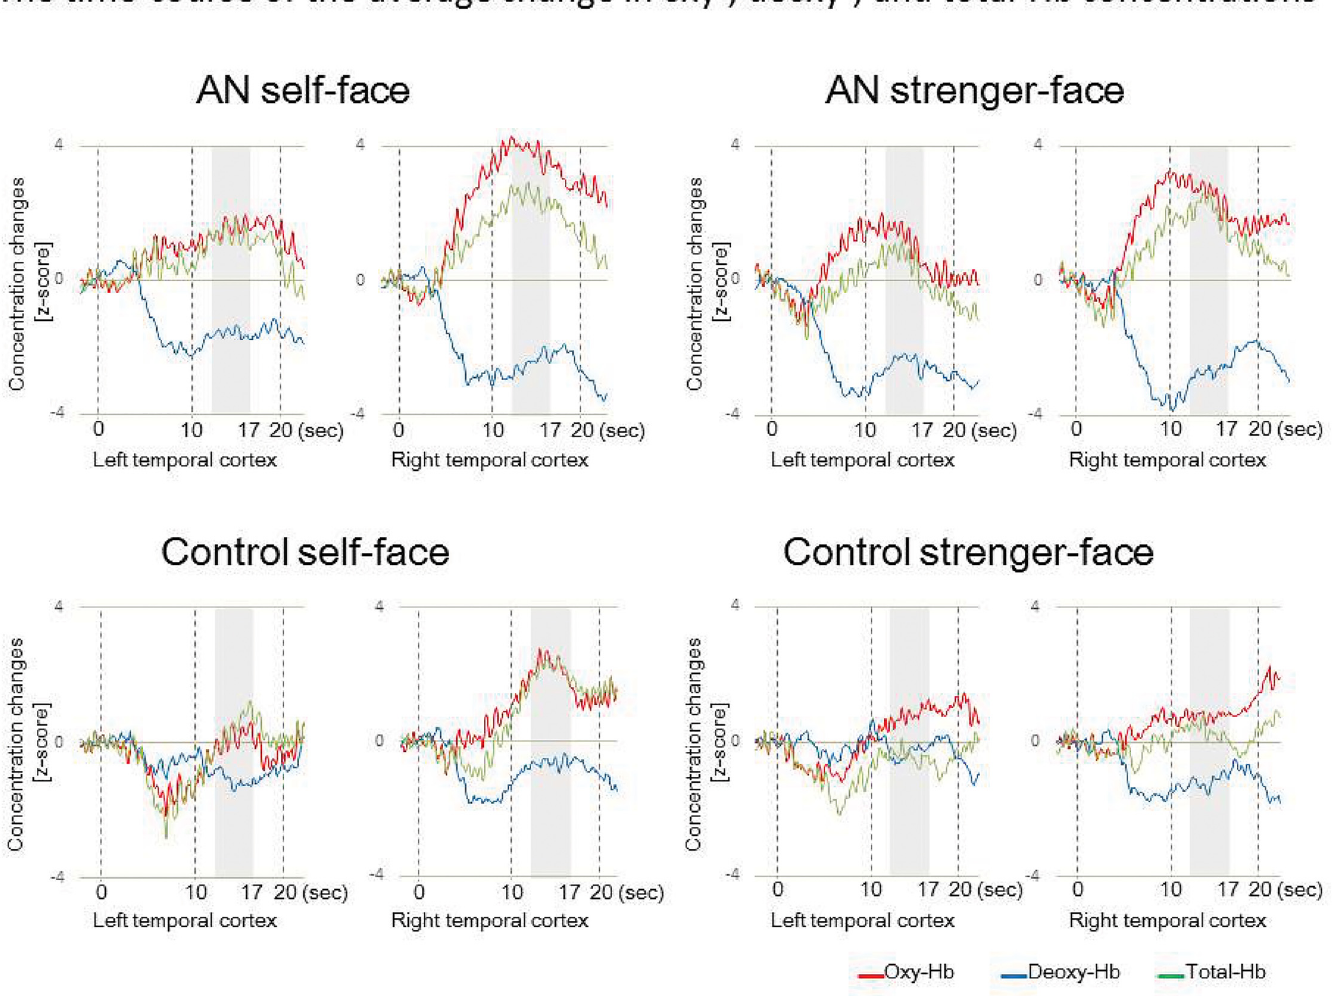
Fig 3. The time-course of the average change in oxy-Hb, deoxy-Hb, and total-Hb concentrations. The time-course of the average change in oxy-Hb, deoxy-Hb, and total-Hb concentrations in the temporal regions of the participants during the presentation of the self-face and stranger-face conditions. Zero on the horizontal axis represents the onset of the test period and the duration of the test period was fixed at 15 s. The area in gray represents the zone that was averaged for statistical